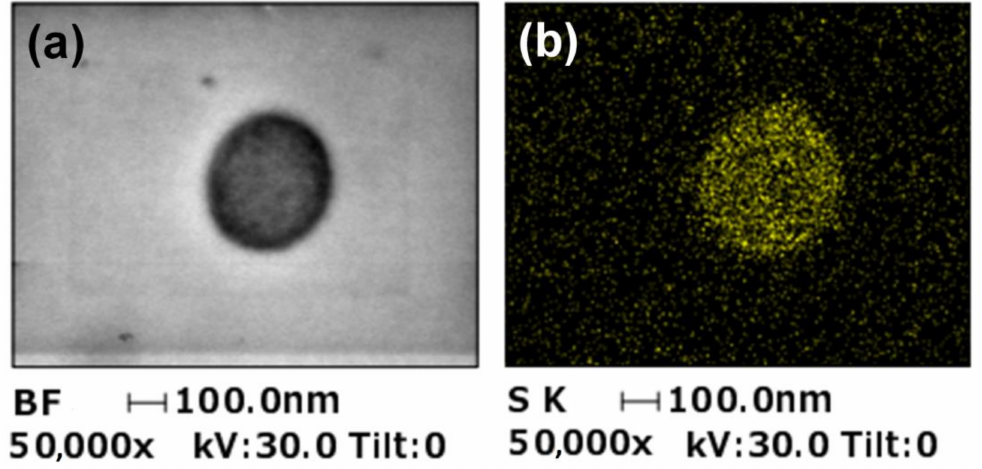
Figure 6. Cross-sectional STEM-EDS images of a single Nafion/PEO (99:1) composite NF. ( a ) Cross- sectional bright-field (BF) STEM image and ( b ) EDS mapping of sulfur atoms in the